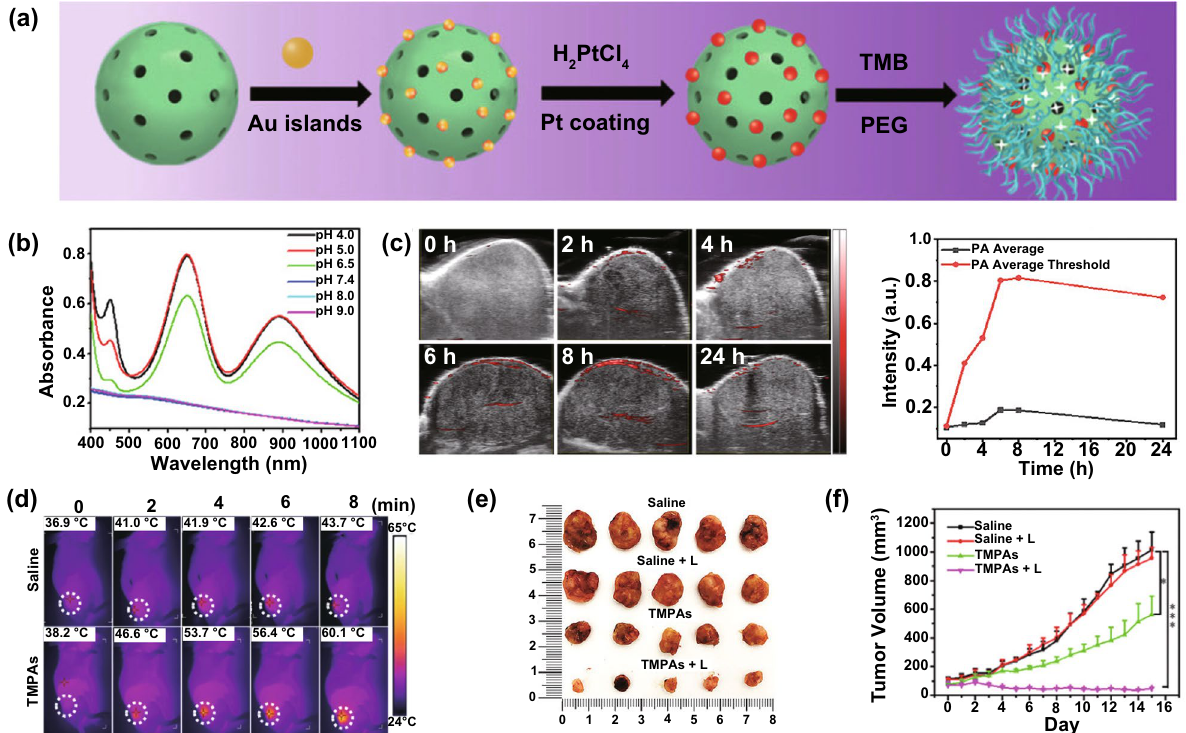
Fig. 14 a Schematic illustration showing the synthetic routine of TMPAs. b UV–Vis–NIR absorption spectra of TMPAs at different pH values. c In vivo PA images of tumor-bearing mice after intravenous injection of TMPAs, and the corresponding time-dependent intensity of PA signals. d IR thermal images of tumor-bearing mice injected with saline or TMPAs after laser irradiation. e , f In vivo antitumor performance of different treatments. Reproduced with permission from Ref. [120]. Copyright 2021, WILEY–VCH